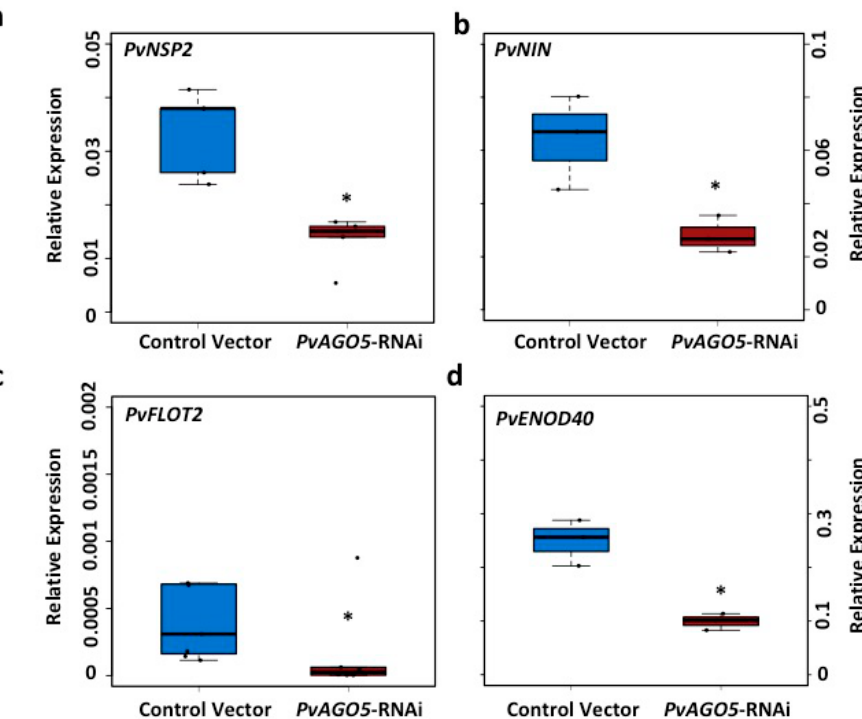
Figure 3. Down-regulation of PvAGO5 affects the expression of symbiotic genes. Rhizobia-triggered expression of ( a ) Nodulation-signalling pathway2 ( PvNSP2 ); ( b ) Nodule inception protein ( PvNIN ); ( c ) Flotillin2 ( PvFLOT2 ) and ( d ) Early nodulin40 ( PvENOD40 ) in control- and PvAGO5 -silenced common bean transgenic roots. Data shown was obtained from six independent biological replicates, each one containing four transgenic roots from the same number of composite plants. One-way ANOVA followed by a Tukey HSD test was performed. Asterisk indicates a significant difference ( p -value < 0.01).